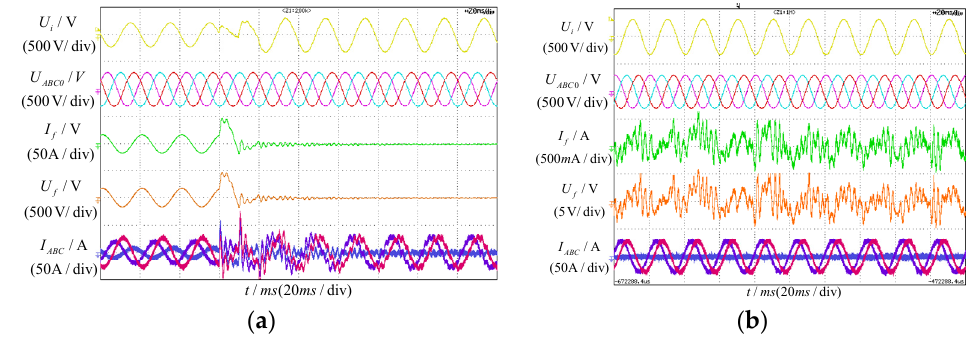
Figure 13. Experiment waveforms: ( a ) experiment waveforms under transient state; ( b ) experiment waveforms under steady state.